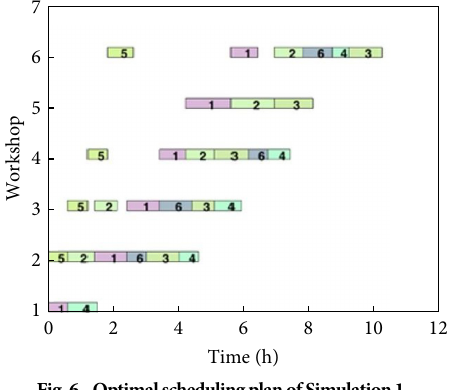
Fig. 6 Optimal scheduling plan of Simulation 1.